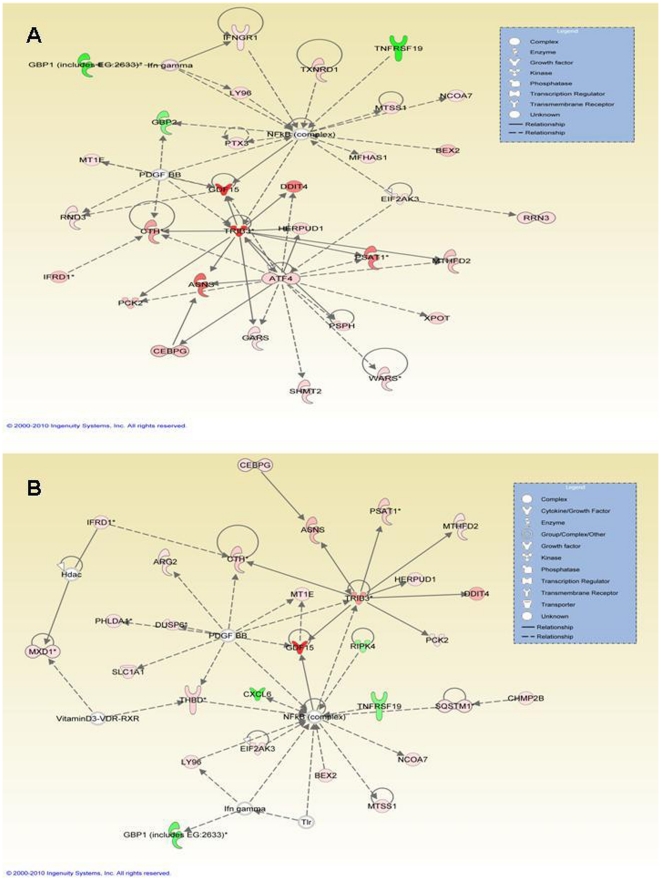
Functionally related gene networks constructed from the (A) normal untreated vs normal rottlerin-treated comparison or (B) SSc untreated vs SSc rottlerin-treated comparison.Differentially expressed genes for each comparison were entered into Ingenuity Pathwork Analysis (IPA) software v 5.0. Nodes represent genes, with their shape representative of the functional classification of the gene product as depicted in the inset box. All of the upregulated genes are displayed in red whereas all of the downregulated genes are displayed in green and the degree of differential expression is reflected by the intensity of the color, with darker colors indicating a greater level of differential expression.